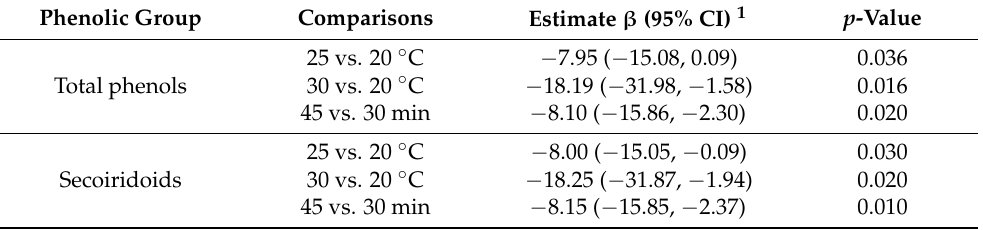
Table 3. Estimated β value and p -value for the concentration of total phenols, the phenolic groups, and the major secoiridoids (oleuropein aglycone, oleacein, ligstroside aglycone, and oleocanthal) adjusted for the RI and with a margin of error of 95% over malaxation temperature and time. p values and estimated β value for the kernel